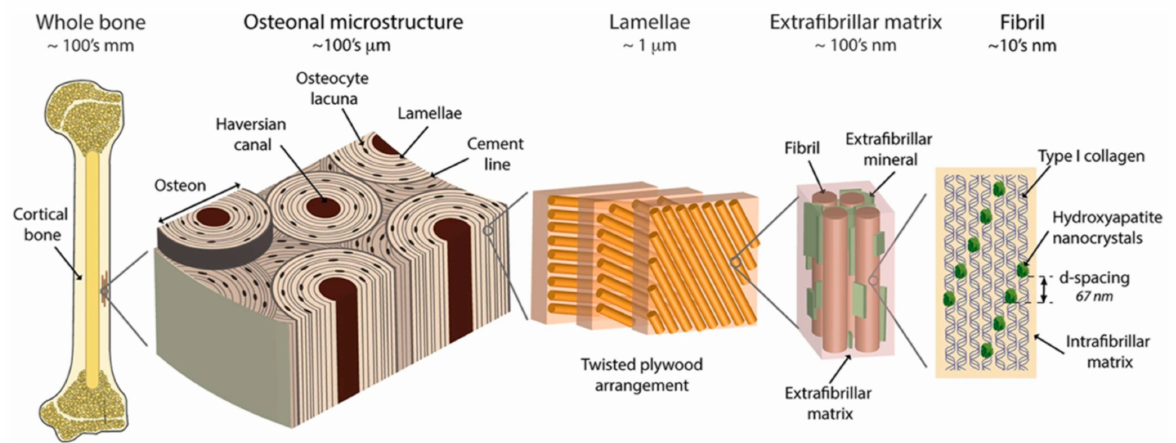
Figure 1. Hierarchical structure of human cortical bone with the presence of hydroxyapatite mineral nanocrystals (reprinted with permission from Zimmermann et al., 2016